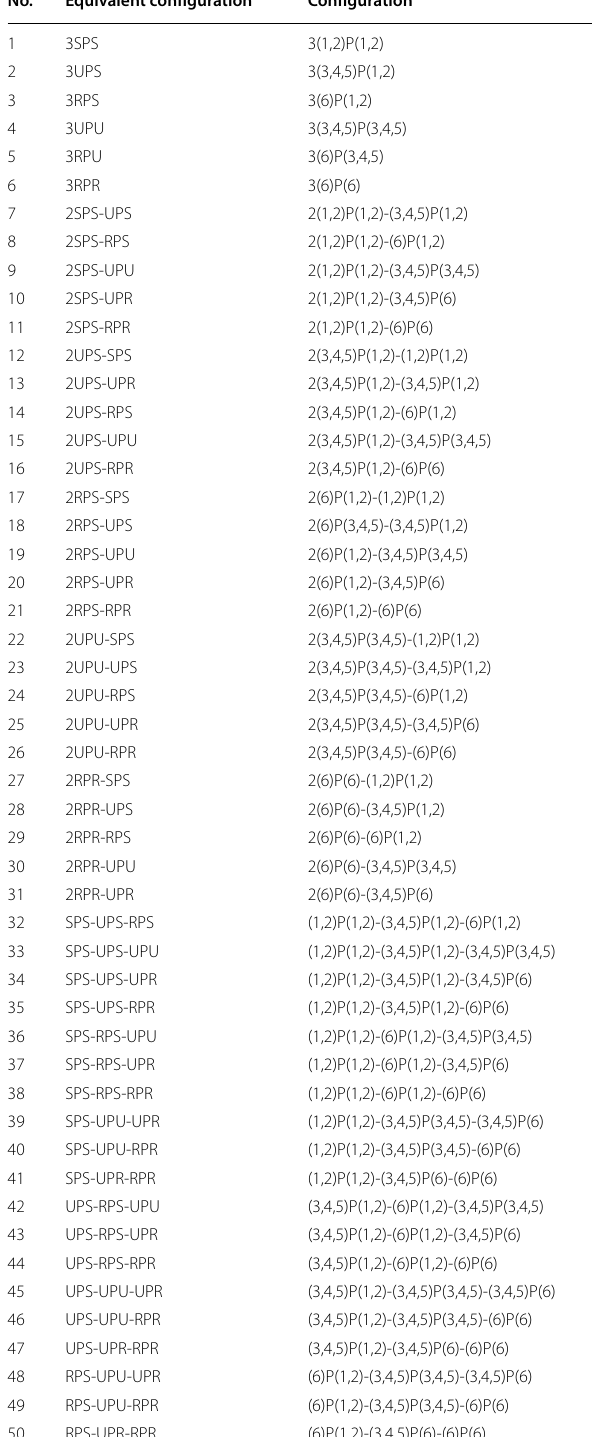
Table 2. The configurations of parallel mechanism